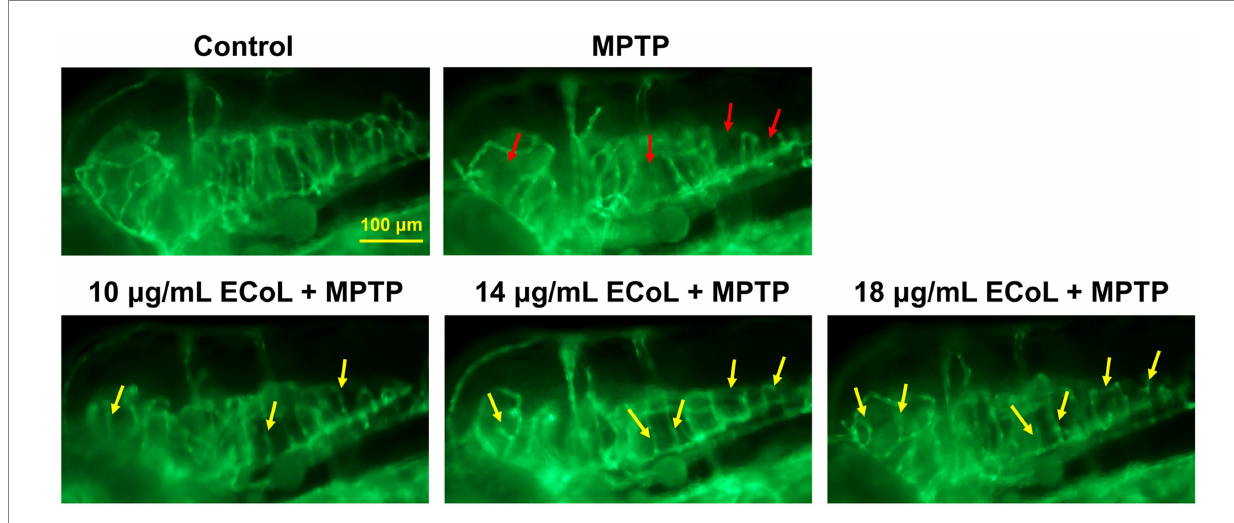
FIGURE 4 Ameliorative effect of ECoL on MPTP-induced loss of neural vasculature. Representative fluorescent microscopy images of flk1:GFP zebrafish in Control, MPTP, and ECoL+MPTP co-treatment groups. Loss of neural vasculature induced by MPTP is indicated by red arrows. Yellow arrows indicate the unmarred or incompletely injured neural vasculature as compared with MPTP treatment. Scale bar, 100 μ